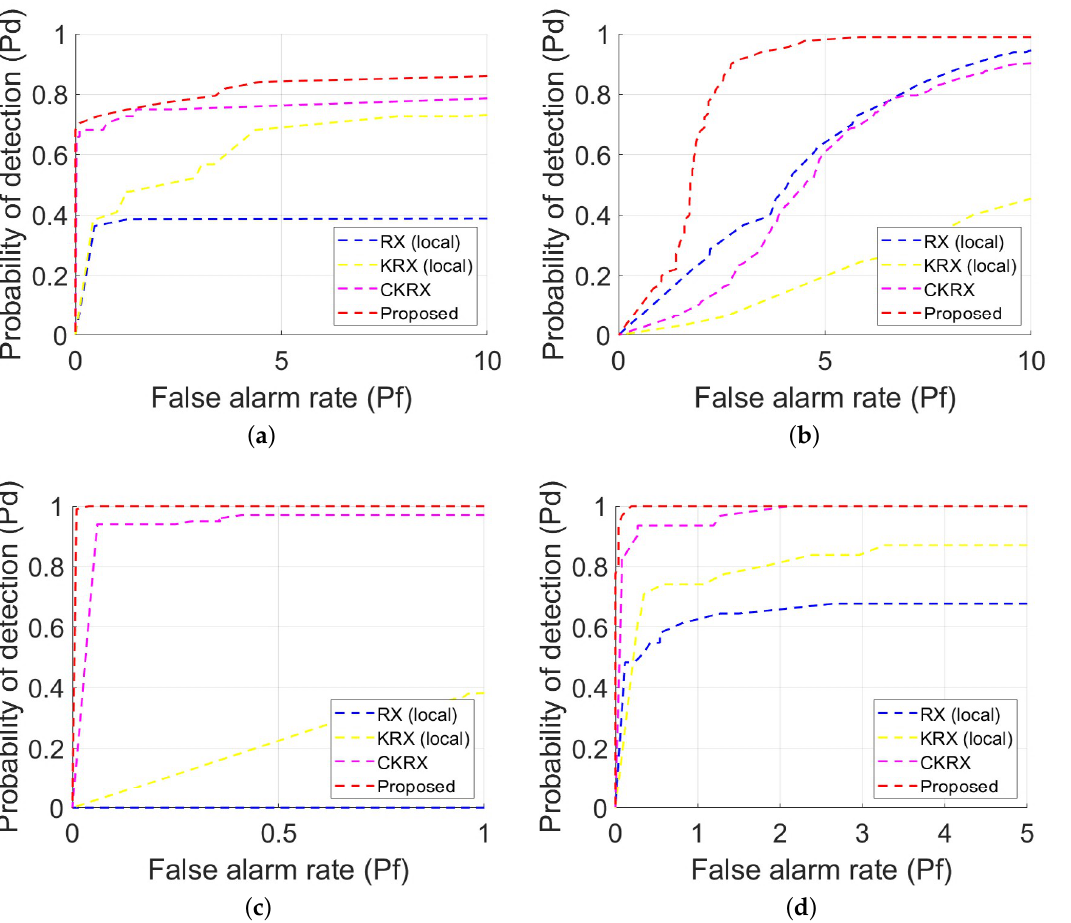
Figure 9. The receiver operating characteristic (ROC) performances by testing the RX-related methods and the proposed method on the dataset: ( a ) Seq 1; ( b ) Seq 2; ( c ) Seq 3; and ( d ) Set